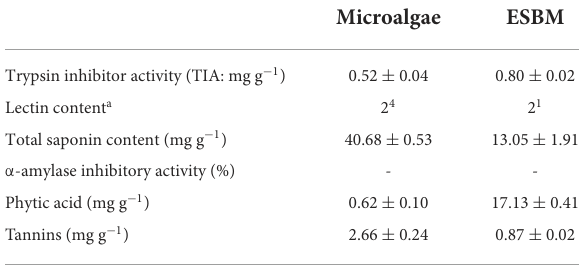
TABLE 2 Amino acid composition of fishmeal, microalgae, and enzyme-treated soybean meal (ESBM).